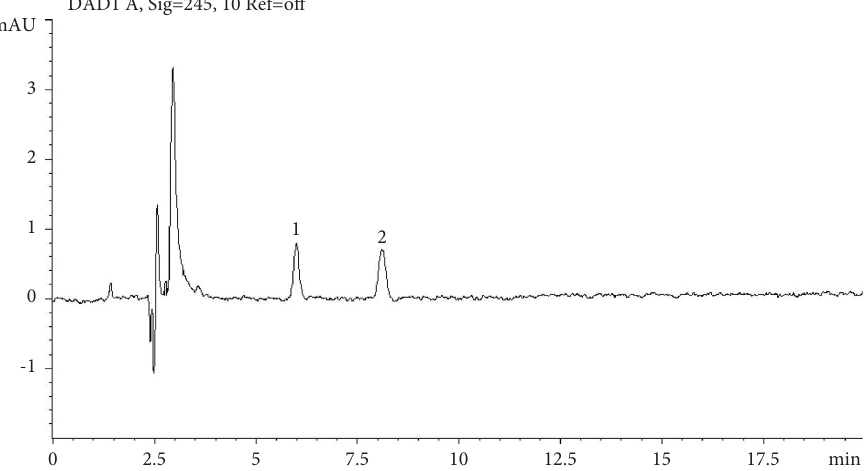
Figure 2: Chromatogram of the spiked sample. Te numbers indicate the peaks of interest at respective retention time (RT). Number 1 indicates the peak of doramectin (RT 5.990), while number 2 is ivermectin (RT 8.100).